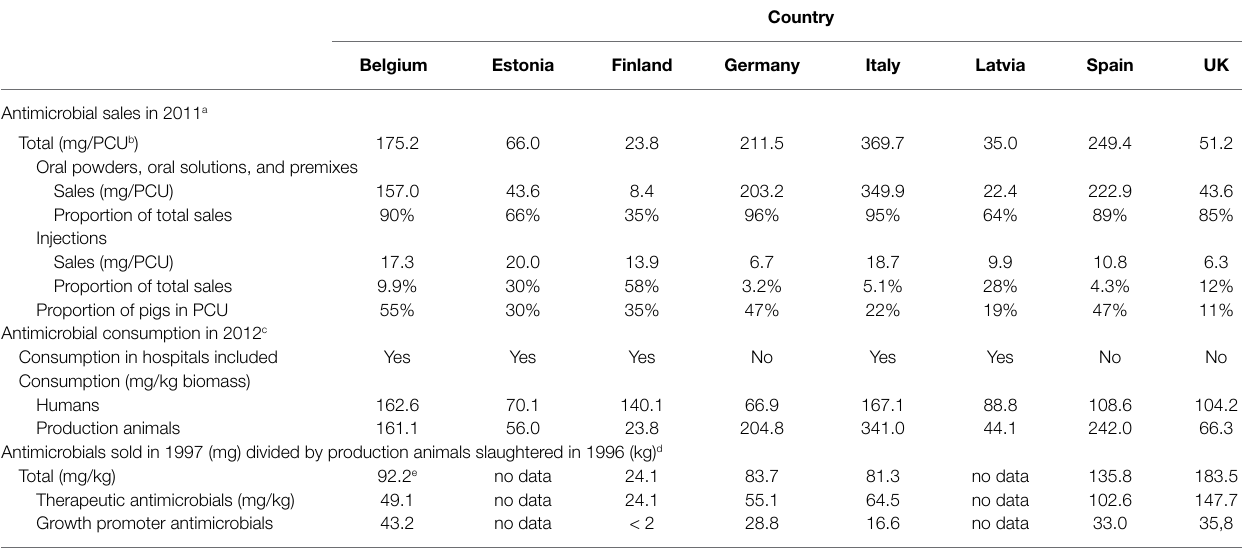
TABLE 4 | Estimated antimicrobial use for food production animals, and for humans as a baseline, in eight European countries based on available